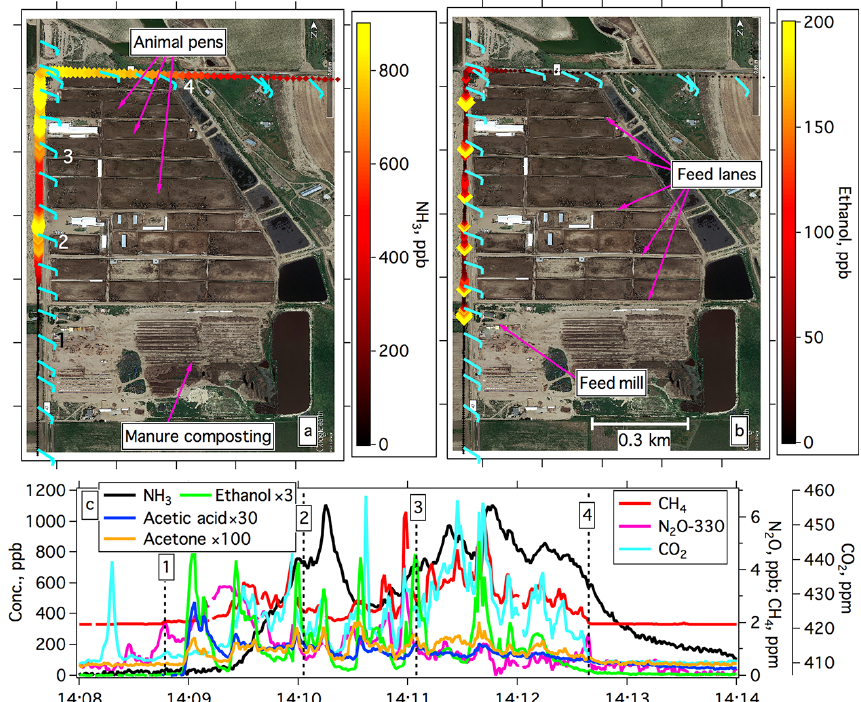
Figure 2. (a, b) Drive track of mobile laboratory color- and size-coded by NH 3 (a) and ethanol (b) concentrations downwind of a dairy farm (dairy no. 1). The prevailing wind is shown by wind barbs (light blue flags) in the map. (c) Time series of NH 3 , CH 4 , CO 2 , N 2 O, ethanol, acetic acid and acetone measured downwind of the dairy farm. Numbers (1–4) in panels (a) and (c) are used to allow for alignment of the mobile laboratory locations on the map with the corresponding time series in panel (c)